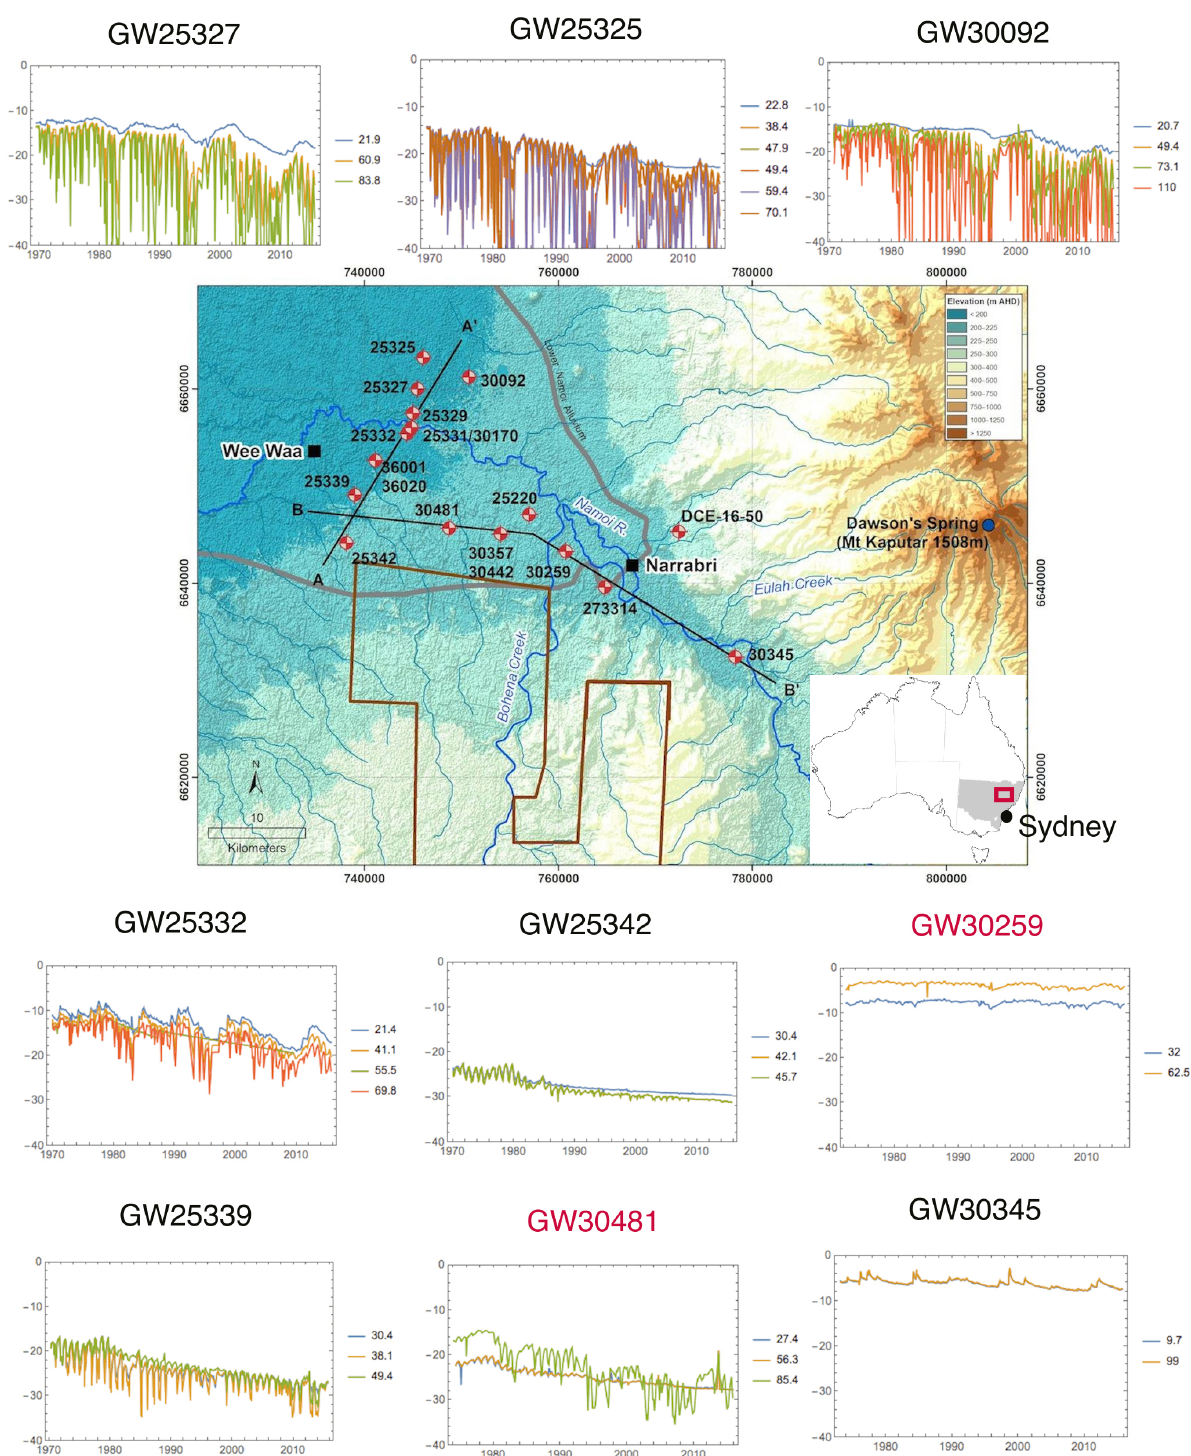
Figure 1. Map of the study area and sample locations, along with the location of the study area in Australia. Accompanying hydrographs show the groundwater level response in different piezometers throughout the study area (groundwater level data sourced from BOM, 2017). The different colours in the hydrographs represent the different monitoring bores in the nested set. The bottom of the slotted interval for each bore is shown in the key. The x axis in each hydrograph is the year (1970–2010) and the y axis is depth (between 0 and 40m below ground surface, b.g.s.). The two locations with red text highlight areas where the hydrograph heads show clear GAB contribution, with the deeper piezometer showing a higher head than the shallow one. The remaining locations show no apparent GAB contribution to the LNA based on the hydrograph